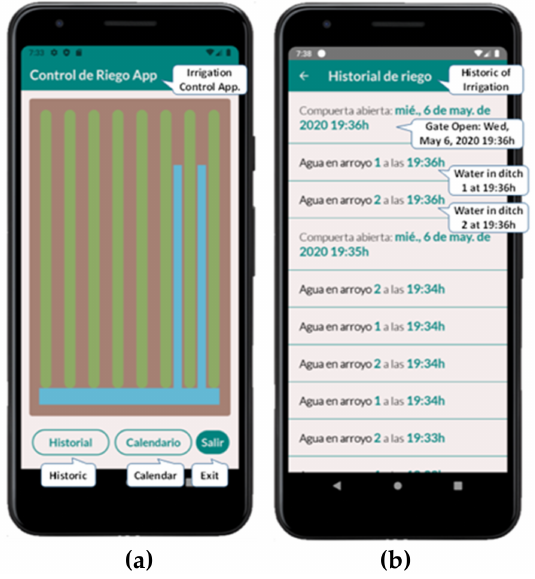
Figure 13. ( a ) Animated screen during the monitoring; ( b ) screen of irrigation